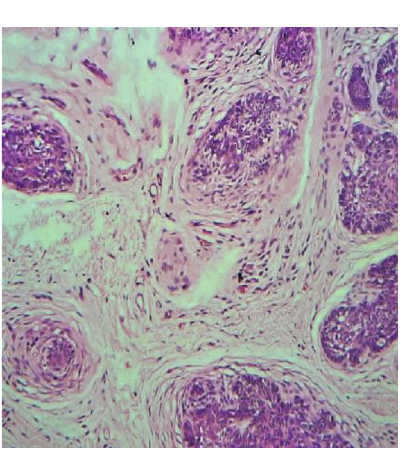
Figure 6: Prominent perilobular connective tissue sheath (H&E, high power, ∗